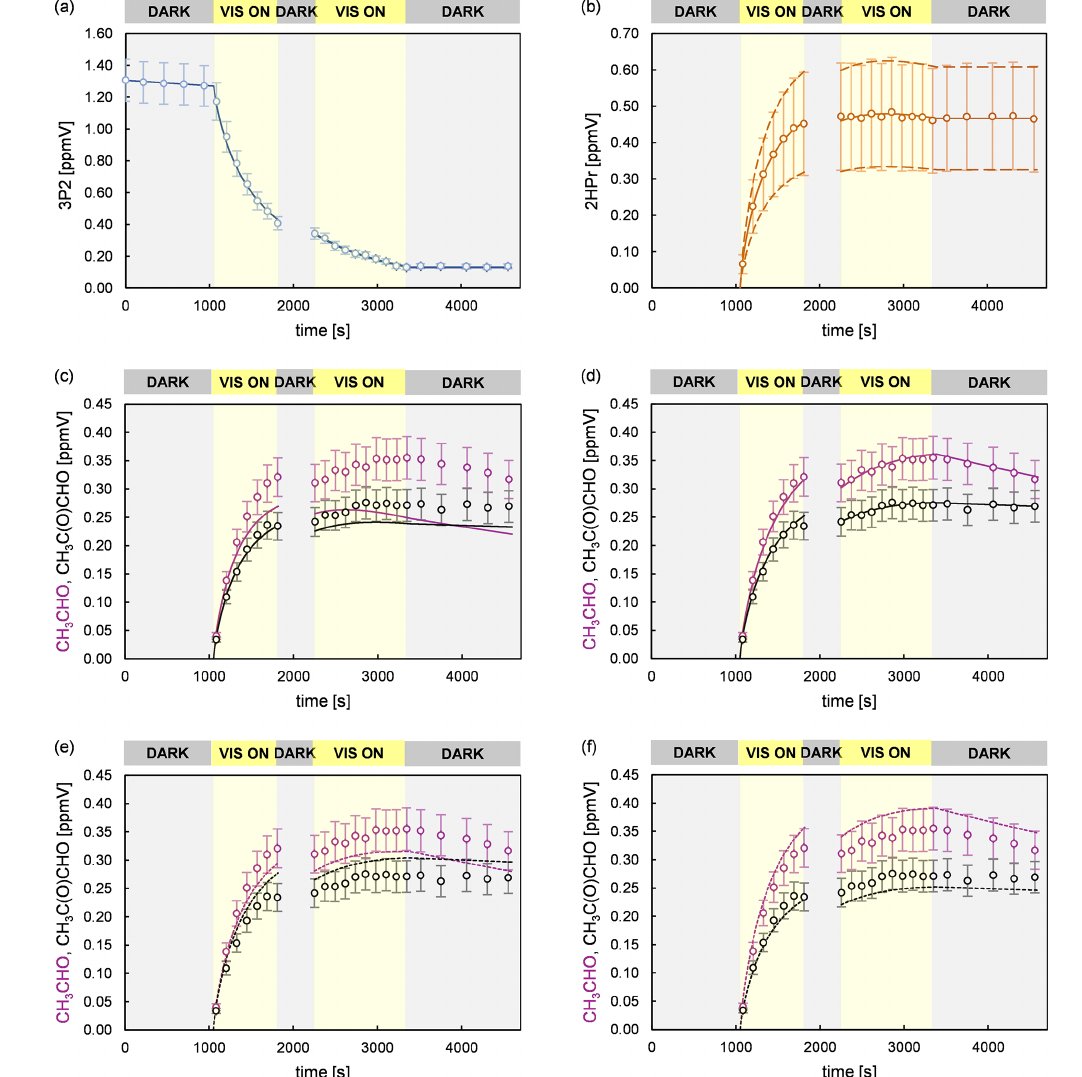
Figure 7. Experimental and simulated time profiles for a 3P2 + OH experiment, performed in the 1080L chamber, with a supplementary addition of methyl nitrite and NO during the second dark phase of the experiment. The experimental set-up did not allow the quantification of CO 2 . The circles represent the experimental data. The error bars represent the accuracy error for each species. The lines show the simulated profiles of (a) 3P2 and (b) 2HPr assuming the average yield (solid line) and the upper and lower limit (dashed lines). The simulated profiles of acetaldehyde and methyl glyoxal are shown considering the average 2HPr yield (c) without their secondary formation, (d) with the optimum parameters used to reproduce the experimental data, (e) for the lower and upper limit of acetaldehyde and methyl glyoxal (scenario 1), respectively, and (f) for the upper and lower limit of acetaldehyde and methyl glyoxal (scenario 2),